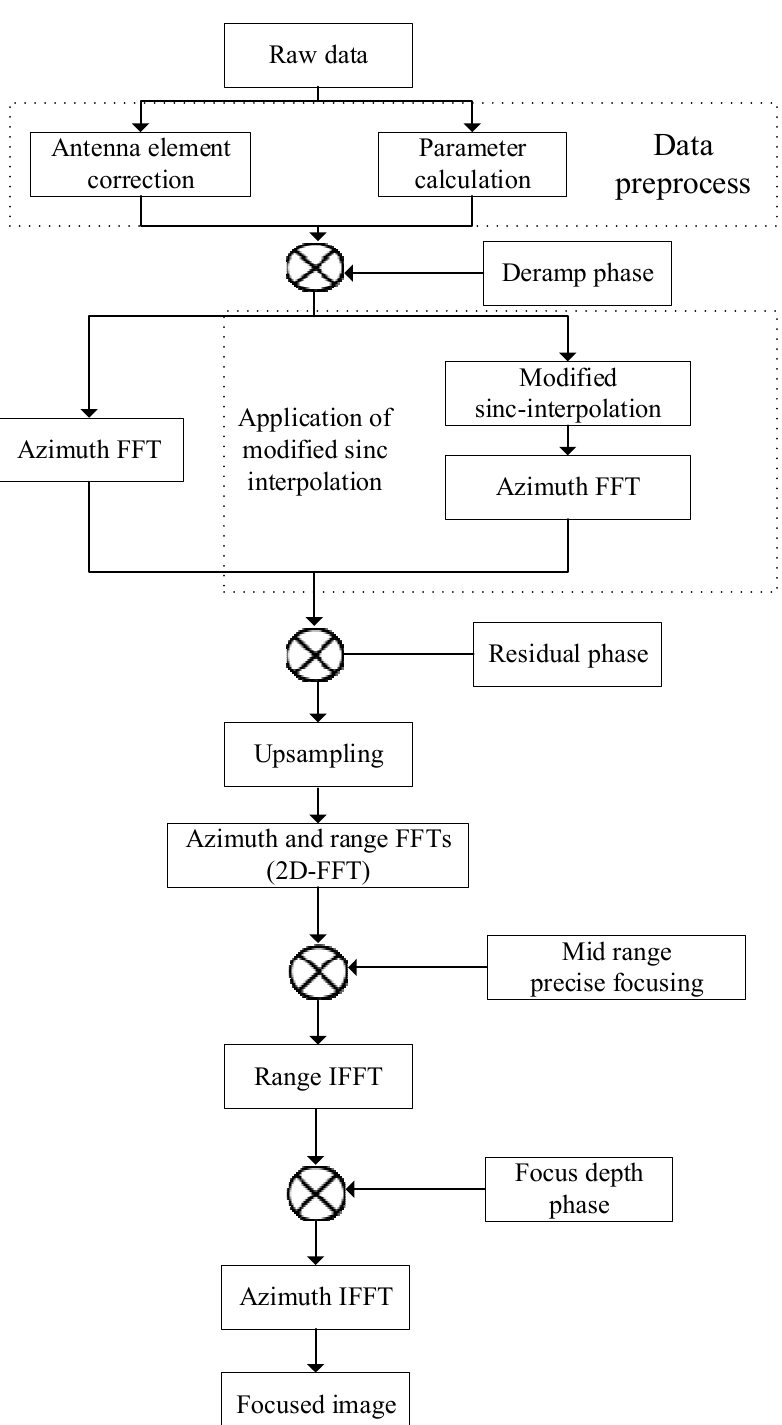
Figure 3. Procedure of the two-step processing approach with the modified sinc interpolation. For the nonuniformly sampled signal, the modified sinc interpolation is needed. After multiplying s a ( η ) with h ( η ) , the azimuth signal turns to be bandlimited, and the modified sinc interpolation can be implemented to reconstruct the uniformly sampled signal after this step. It should be noticed that, the chirp signal is generated with respect to the variant PRI